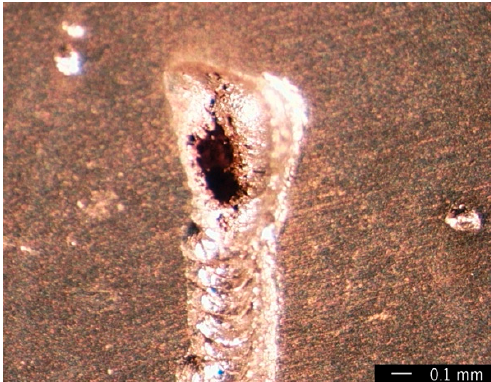
Figure 2. Shallow localized attack on the specimen after 790 h of exposition in saturated Ca(OH) 2 solution added with 0.23 M tartrate and 0.23 M chloride ions. Chlorides were added 72 h after the inhibitor.